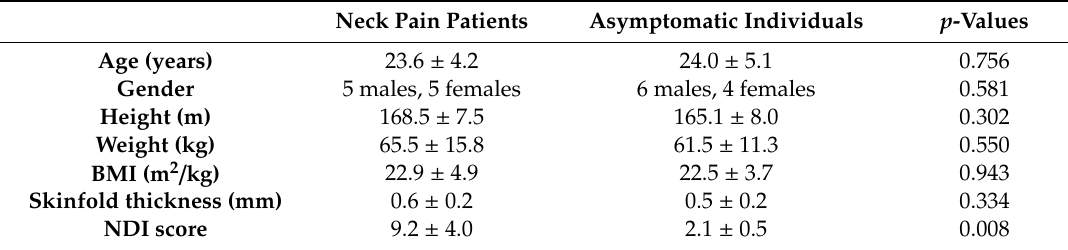
Table 1. Characteristics of the demographic data for patients with nonspecific neck pain and asymptomatic